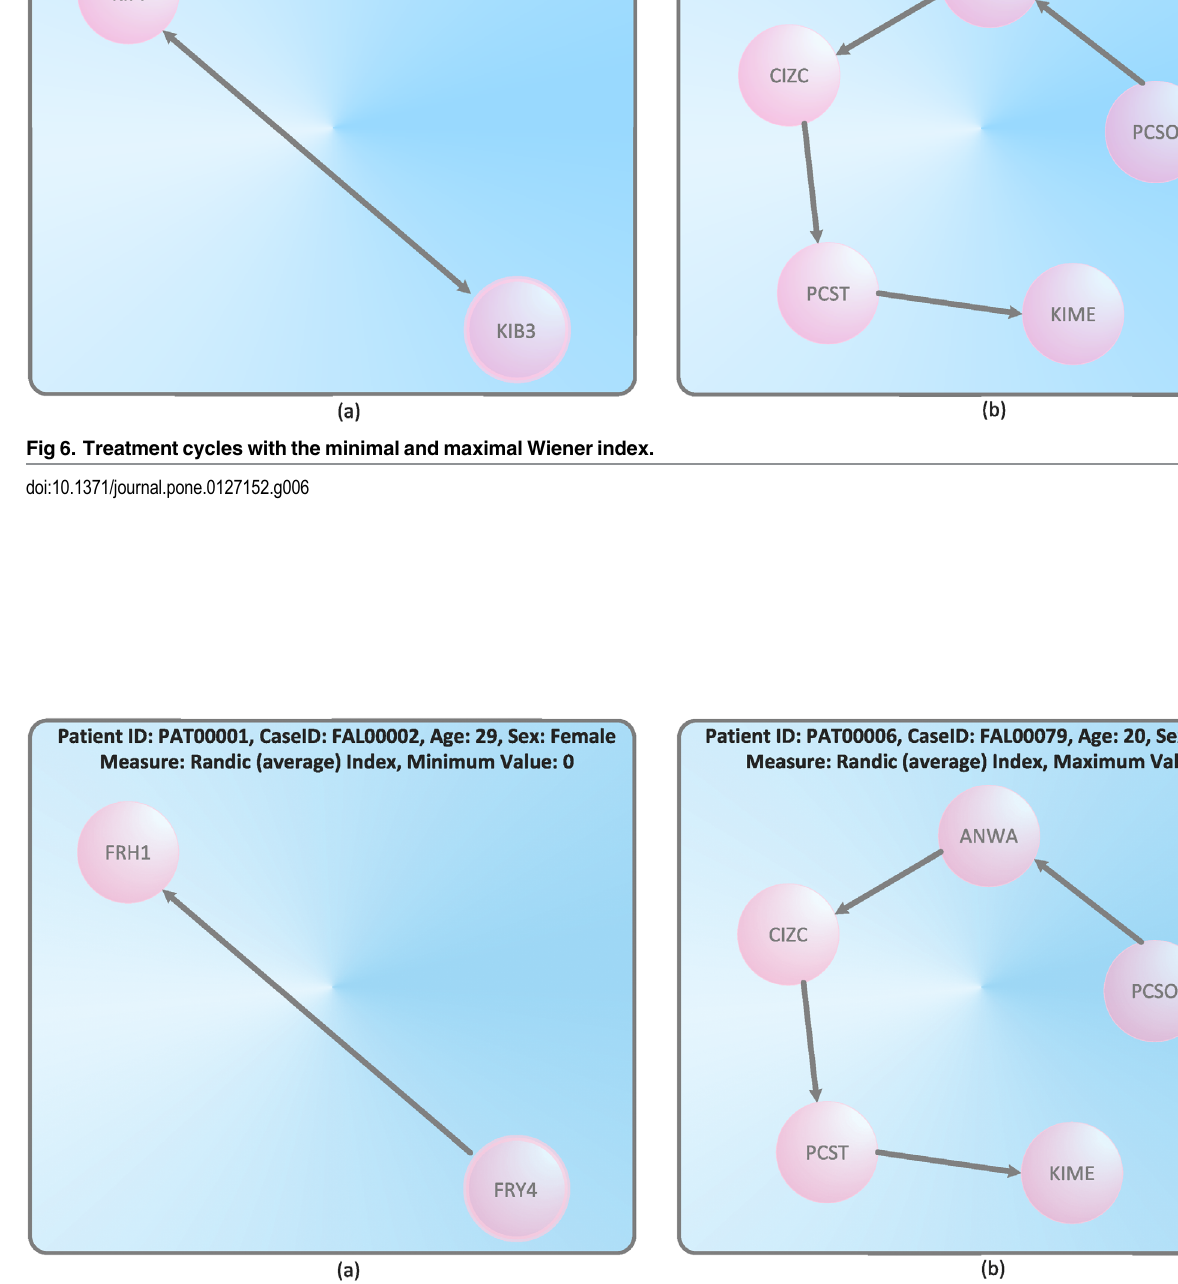
PLOS ONE | DOI:10.1371/journal.pone.0127152 June 1,